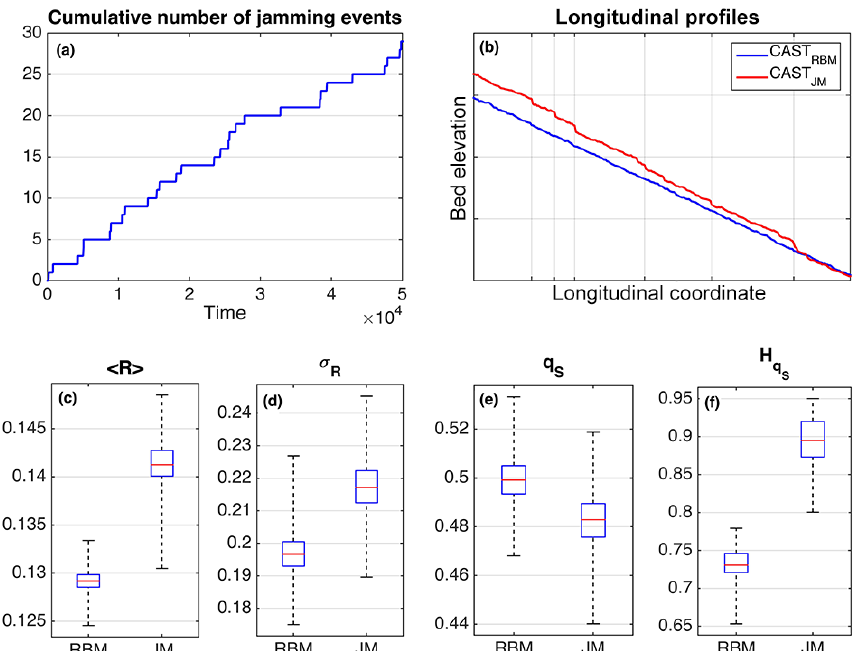
Figure 6. Comparison between simulations without jamming (RBM) and with jamming (JM) for i R = 0 . 5 and E = 1 . 25. (a) Cumulative number of jammed cross sections. (b) Longitudinal profiles at the end of the simulations. (c) Box plots of the instantaneous values of mean relative exposure. (d) Box plots of the instantaneous values of standard deviation of relative exposure. (e) Box plots of the instantaneous values of specific sediment flux. (f) Box plots of the values of Hurst exponent of specific sediment flux computed from the 20